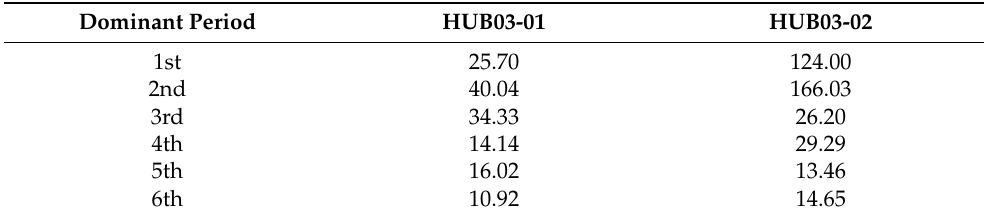
Table 2. Dominant periods (hours/cycles) in descending order from the 1 st to the 6 th for HUB03-01 and HUB03-02.